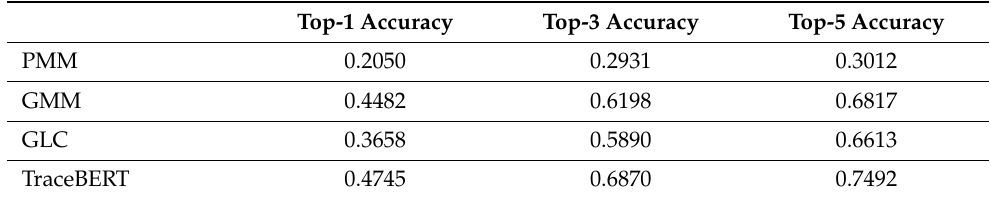
Table 1. Overall accuracy comparison between TraceBERT and the three baseline approaches, namely the personal Markov model (PMM), global Markov model (GMM), and global location co-visits (GLC).